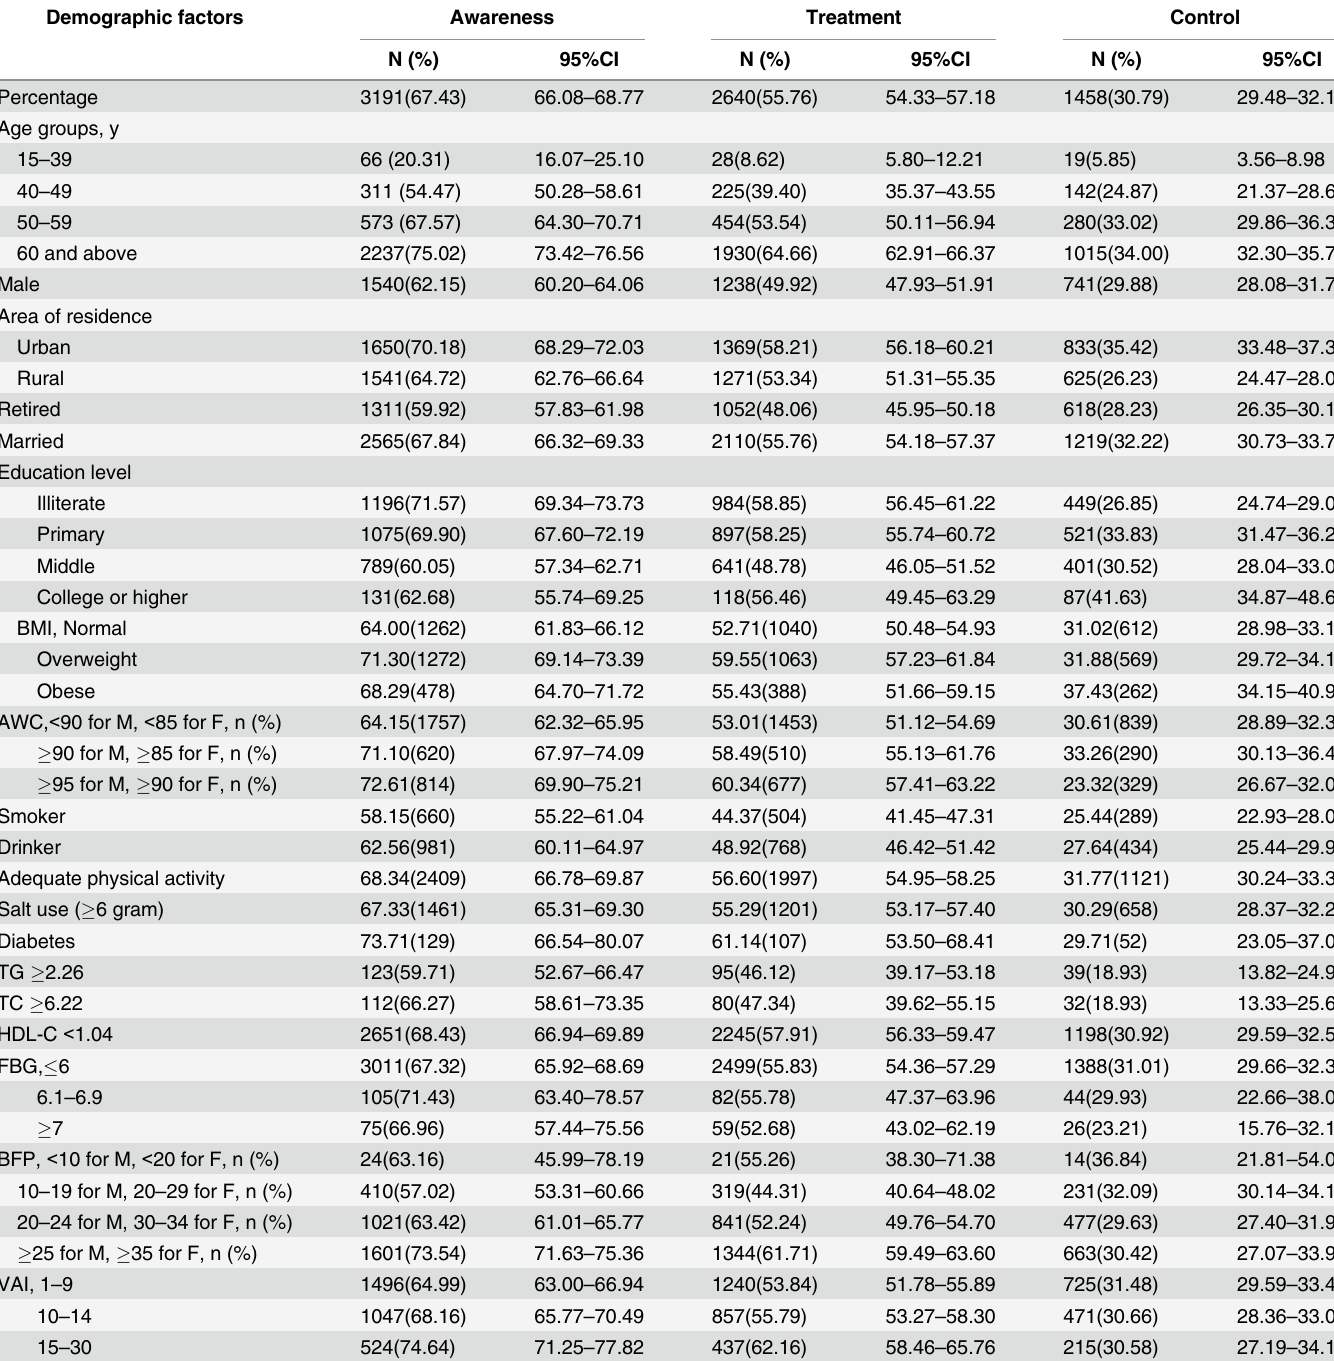
Table 2. Percentage of awareness, treatment and control of hypertension among hypertensives in Southern China in 2013 (N = 4735). Demographic